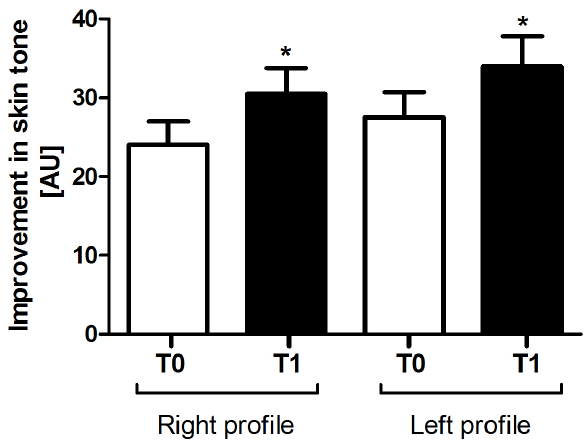
Figure 2. Skin tone at baseline (T0) and after one application of the test product (T1) in the pilot study subjects. Right and left profiles are shown. * indicates P < 0.05.